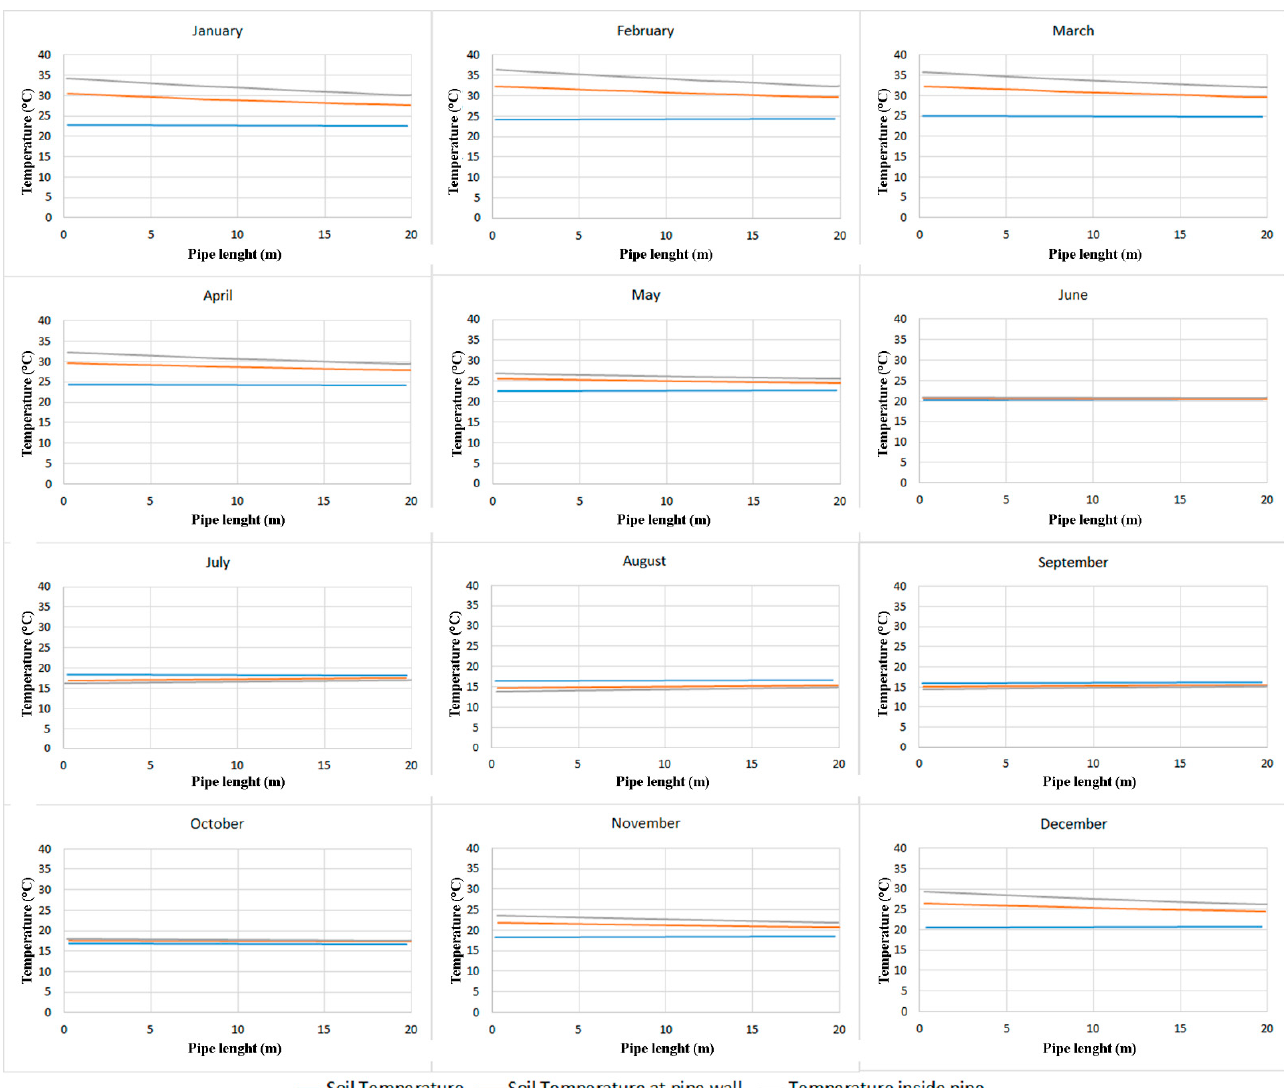
Figure 7. Trends of temperatures along the length of the pipe.